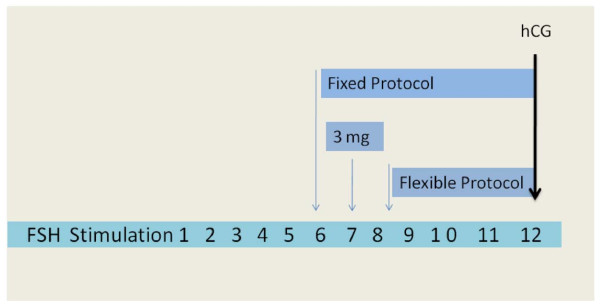
GnRH antagonist protocols. Fixed day 6 protocol: 0.25 mg GnRH antagonist/daily until hCG administration (Albano et al.,F&S 1997)[23]. Single dose protocol. 3 mg GnRH antagonist at day 7 of stimulation (Olivennes et al.,HR 1998)[22]. Flexible dose protocol: 0.25 mg GnRH antagonist when follicles reach >14 mm (Diedrich et al., HR 1994).[21]